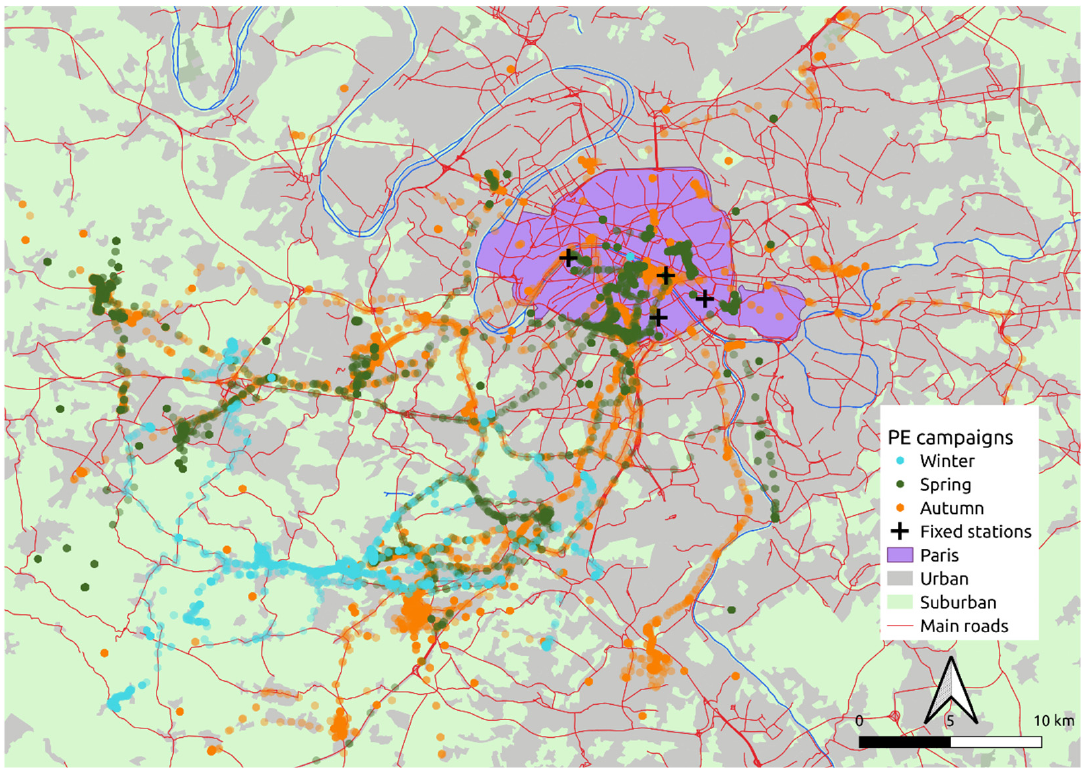
Figure 1. Location of volunteer measurements during the three campaigns over the Île-de-France region as well as the monitoring stations used in this study.